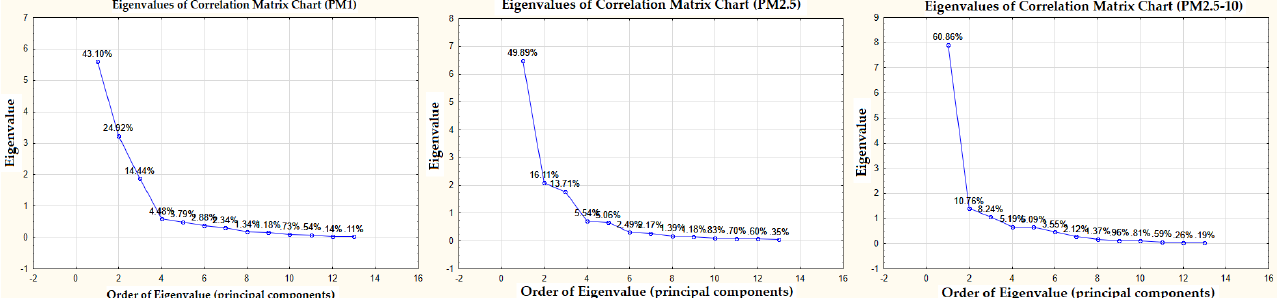
Figure 7. Graphs of ‘‘foothills”—eigenvalues based on PCA.